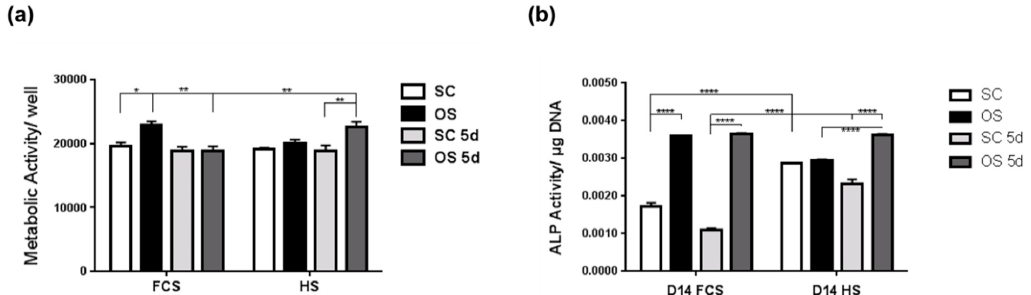
Figure 4. Transient serum exposure for human mesenchymal stem cell cultures with FCS or